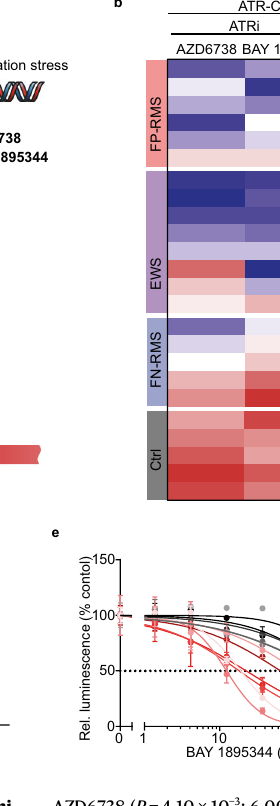
AZD6738 ( P =4.10×10 − 3 ; 6.00×10 − 4 ; 6.30×10 − 3 for EWS, FP-RMS and FN-RMS vs Ctrl, respectively; from left to right, n =8, 6, 5, and 5 biologically independent cells). e Dose-responsecurvesofcellviabilityforFP-RMScelllinestreatedwiththe ATRinhibitorBAY1895344comparedtoprimarymyoblasts( n =3). f IC 50 valuesfor FP-RMS, EWS, FN-RMS and Ctrl cells treated with BAY 1895344 ( P =2.31×10 − 4 ; 4.59×10 − 5 ; 0.116 for EWS, FP-RMS and FN-RMS vs Ctrl, respectively; from left to right, n =8, 6, 5, and 5 biologically independent cells). All statistical analyses cor- respond to two-sided student ’ s t-test; data presented as mean value ± error bars representing standard